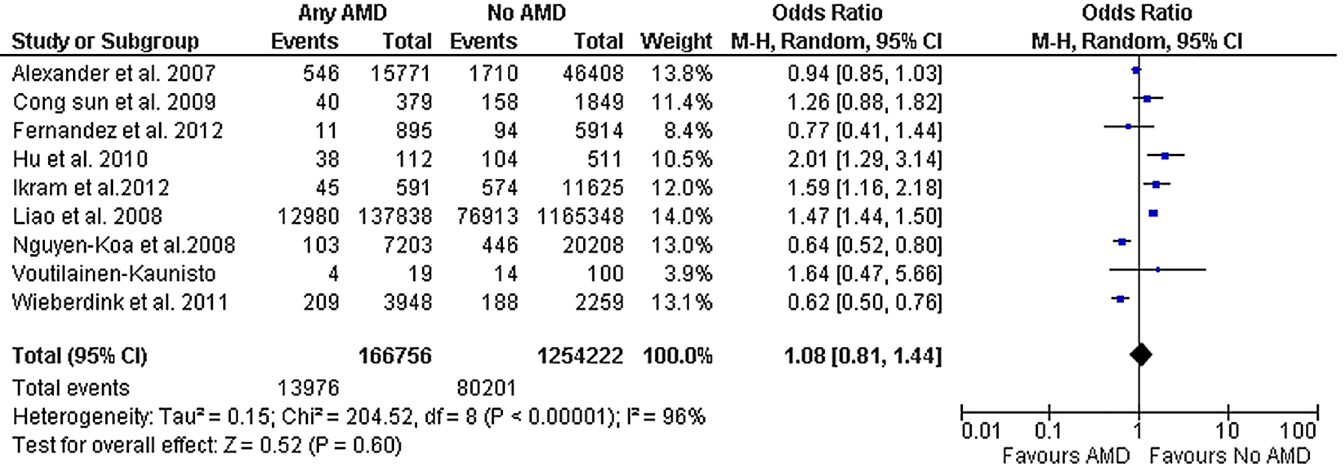
Fig 2. Any AMD and Stroke. Diamond indicates the overall summary for the analysis, width of the diamond represents the 95% CI (Confidence Interval), and boxes represent the weight of individual studies in the pooled analysis. Trials to the left of the vertical line showed a reduction in the risk of stroke events favored AMD; those to the right showed an increase in risk favored No AMD. Abbreviations: AMD, Age-related macular degeneration; M-H, Mantel-Haenszel.